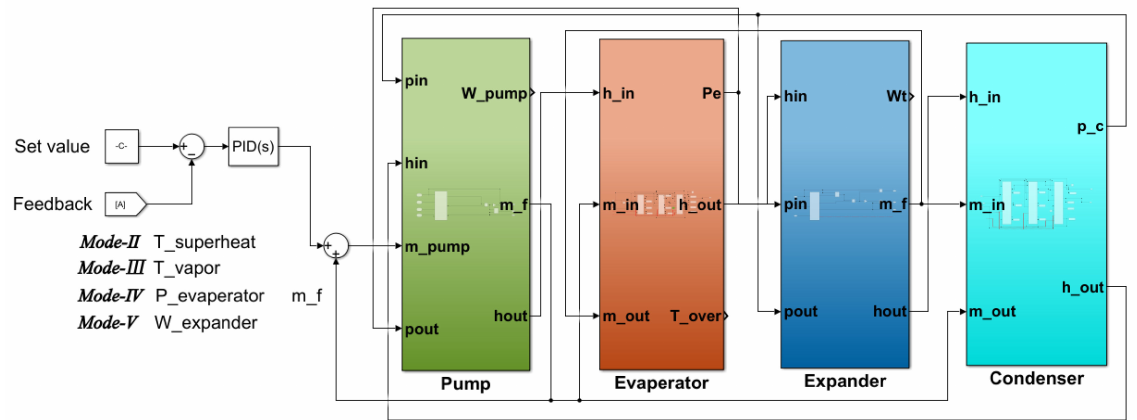
Figure 4. The developed dynamic model of the ORC prototype.